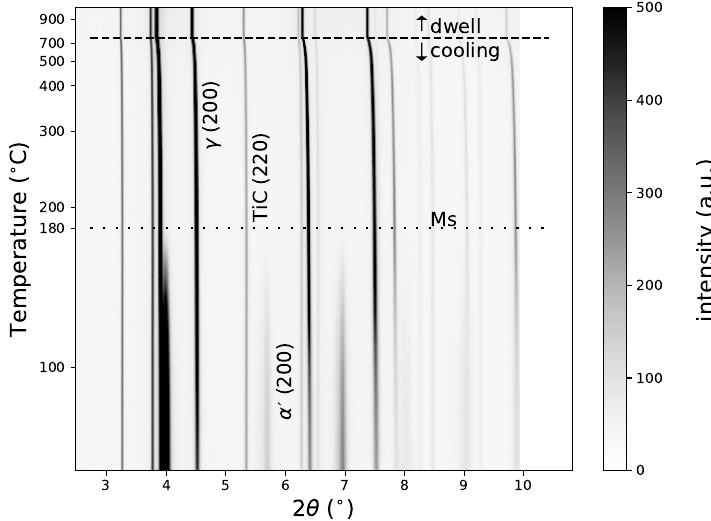
Figure 6. Evolution of diffractograms during cooling.